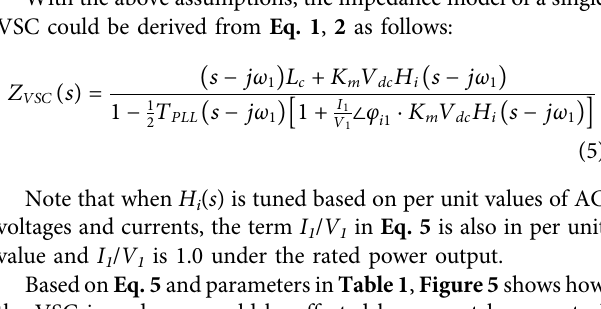
Frontiers in Energy Research |